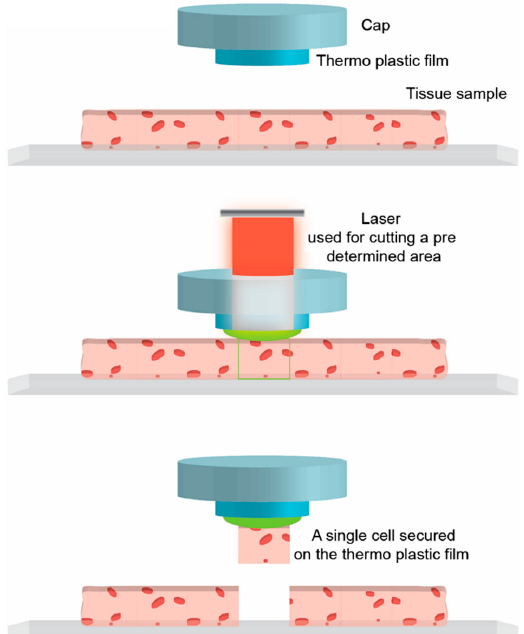
Figure 3. Single-cell laser-assisted microdissection. ( Upper ) The technique utilizes a laser placed on a microscope for visual identification; ( Middle and lower ) the laser can be controlled to dissect out target cells in fixed and live tissue. Several different technologies exist on how the laser works and how the target cell is collected following dissection.